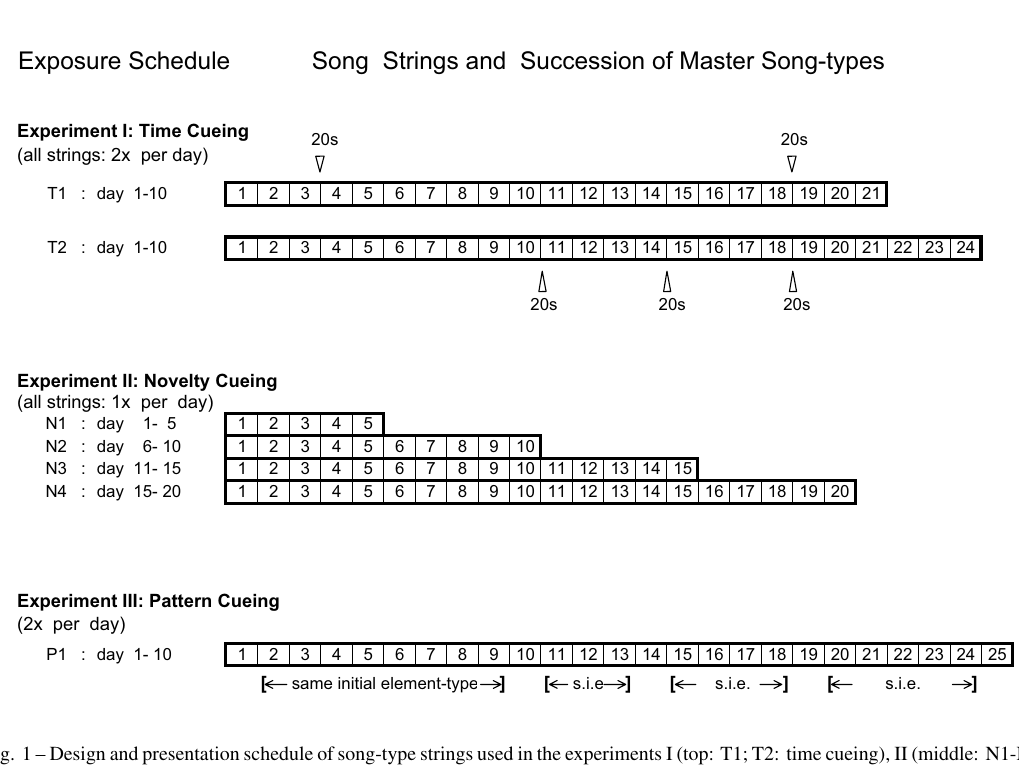
Fig. 1 – Design and presentation schedule of song-type strings used in the experiments I (top: T1; T2: time cueing), II (middle: N1-N4: novelty cueing) and III (bottom: P: pattern cueing). The succession of master song-types in a string is given by numbered cells. Top: Arrows indicate the sequential location where intersong intervals of 20s were introduced in the song succession (intersong spacing otherwise: 4s). Bottom: Groups of song-types which had identical initial song sections are within parenthesis. Interspersed between these different groups were ‘single’ song-types with an initial song section that differed from both the preceding and the following